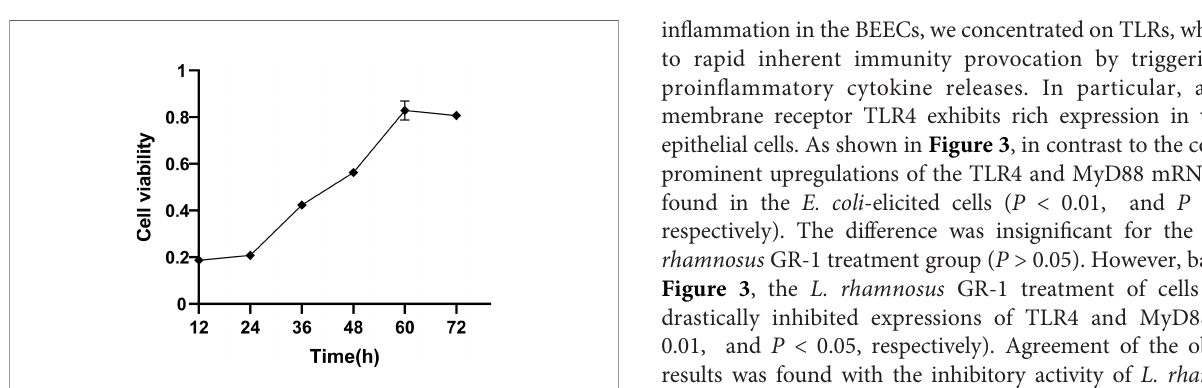
FIGURE 1 | Cell viability in BEECs. Cell viability was detected by MTT at different periods. Data are presented as the mean ± SEM of three